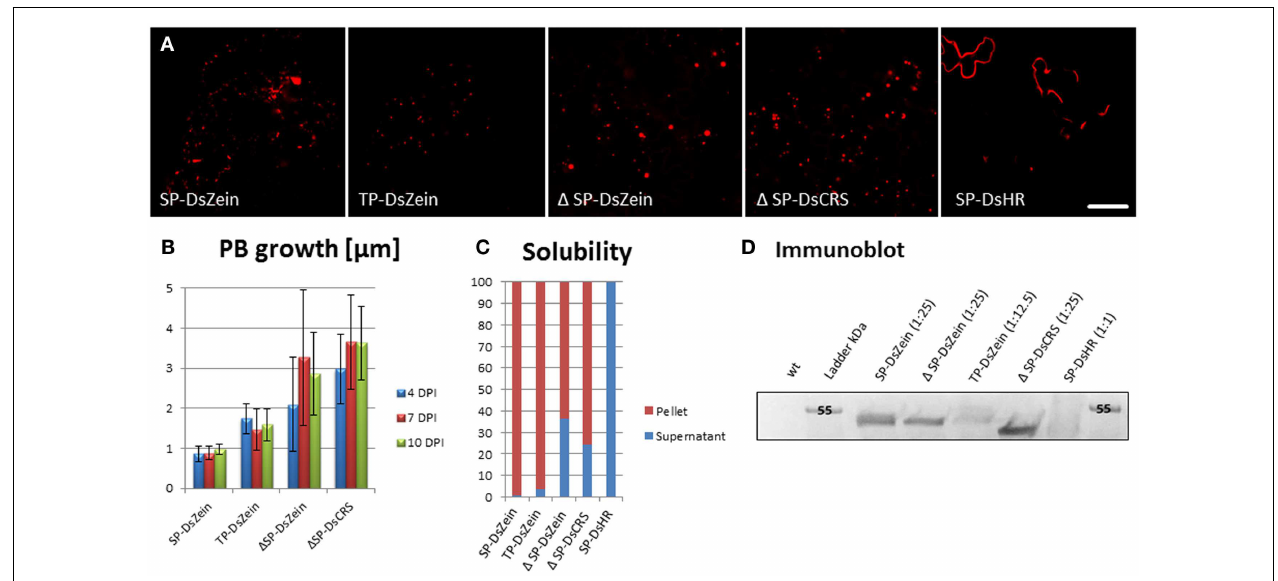
were extracted in PBS (soluble fraction) and pellets were then re-extracted under strong reducing conditions. (D) Immunoblot analysis of total protein extracts from leaf samples. Antiserum against the HIS-tag was used to detect the recombinant